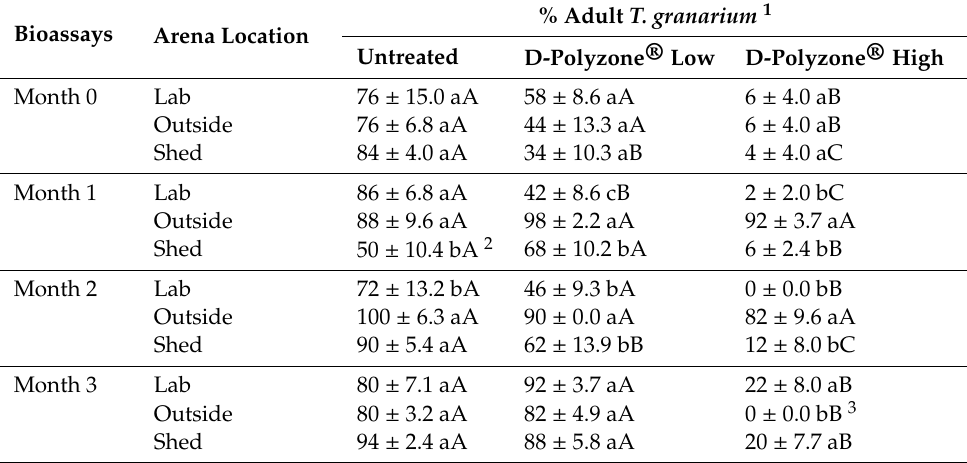
Table 4. Percentage of adult T. granarium (means ± SE) emerging from larvae exposed on untreated arenas or arenas treated with low and high rates of deltamethrin Polyzone ® . Arenas were held either in the laboratory, in an outside area, or inside a shed. Bioassays were conducted 1 week after treatment and at 1, 2, and 3 months post-treatment 1